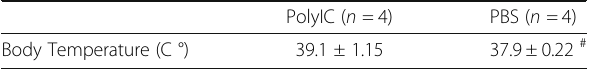
Table 1 Average maternal body temperature 3 h after PolyIC or PBS injection